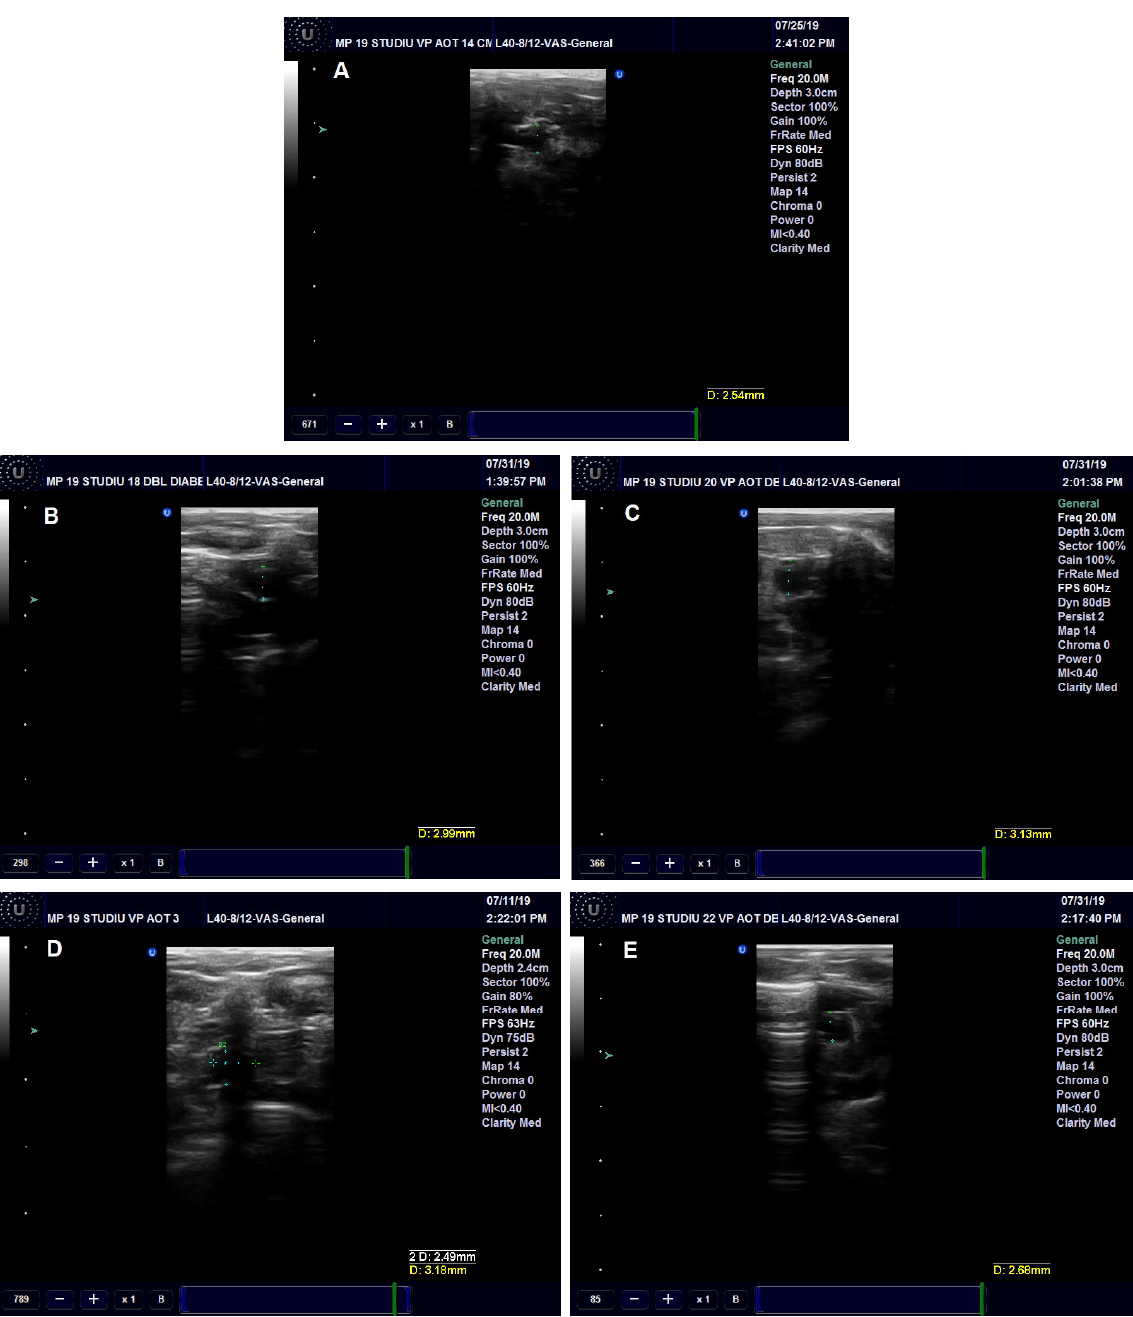
Figure 5. Ultrasound examination of the descending aorta diameter in rats with 9 months of HFD and the last month with experimental-induced diabetes mellitus and treatment: CMC (carboxymethyl- cellulose) group ( A ), Insulin group ( B ), Pioglitazone group ( C ), AuNPsCM (gold nanoparticles functionalized with Cornus mas L. extract) group ( D ) and CM ( Cornus mas ) group ( E ).